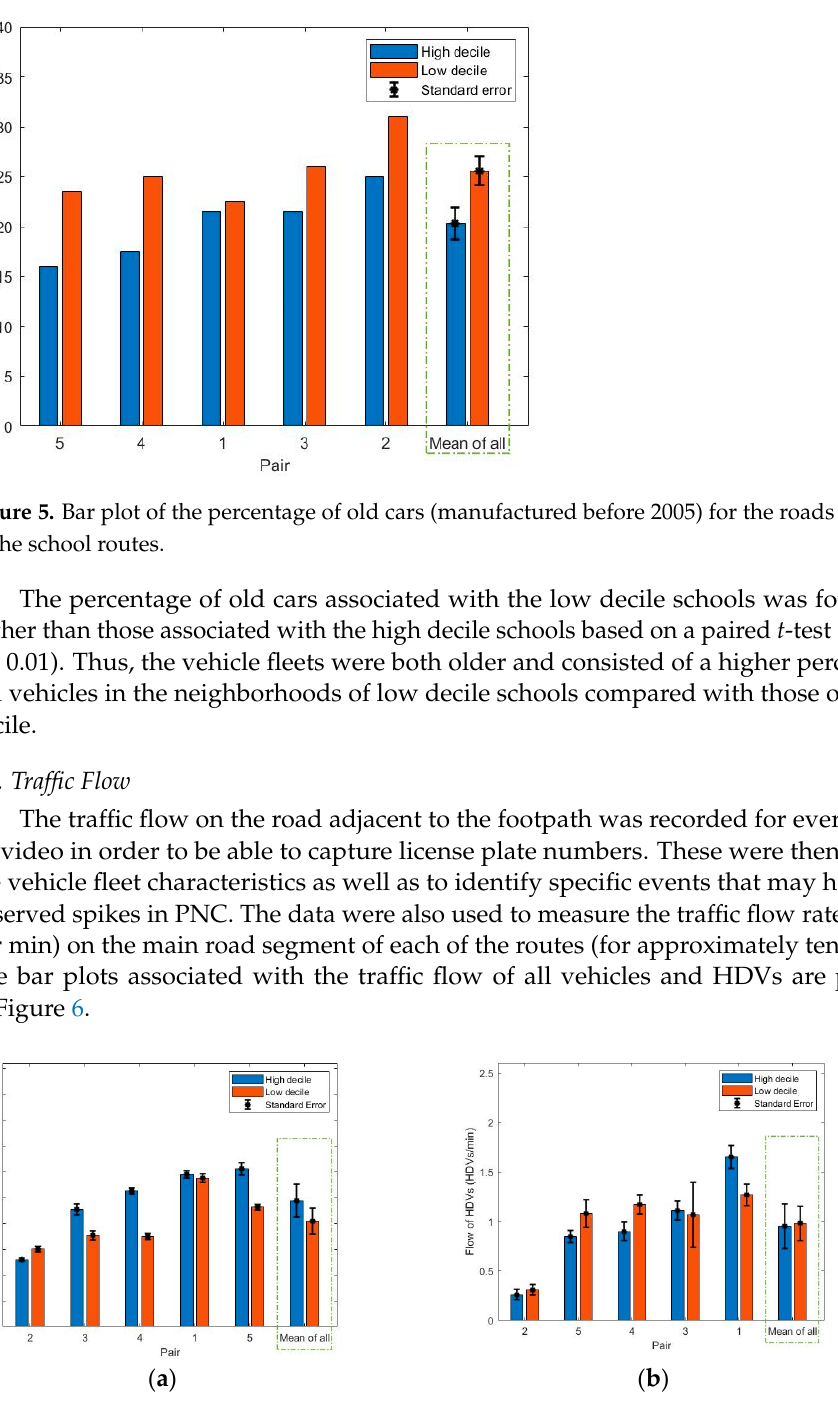
Figure 6. Bar plot of ( a ) traffic flow of all vehicles (vehicles/min), ( b ) traffic flow of HDVs (HDVs/min) along the main road segment (high traffic component) of each route collected over the 7–8 days of observation.